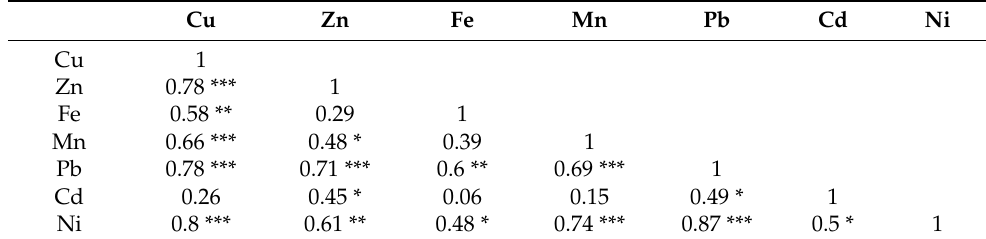
Table 5. Pearson’s Correlation Matrix of heavy